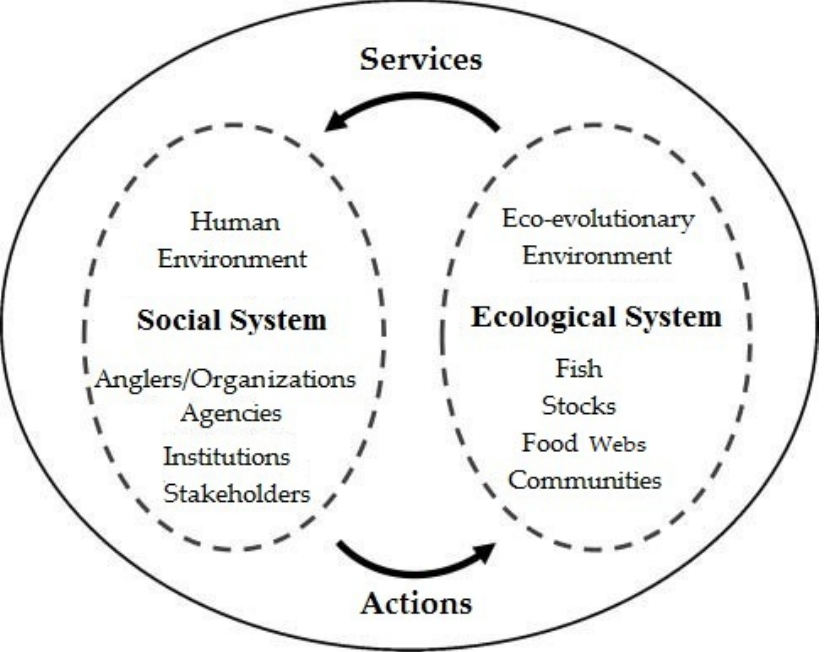
Figure 2. A schematic view of recreational fisheries as SESs (modified from [55]).